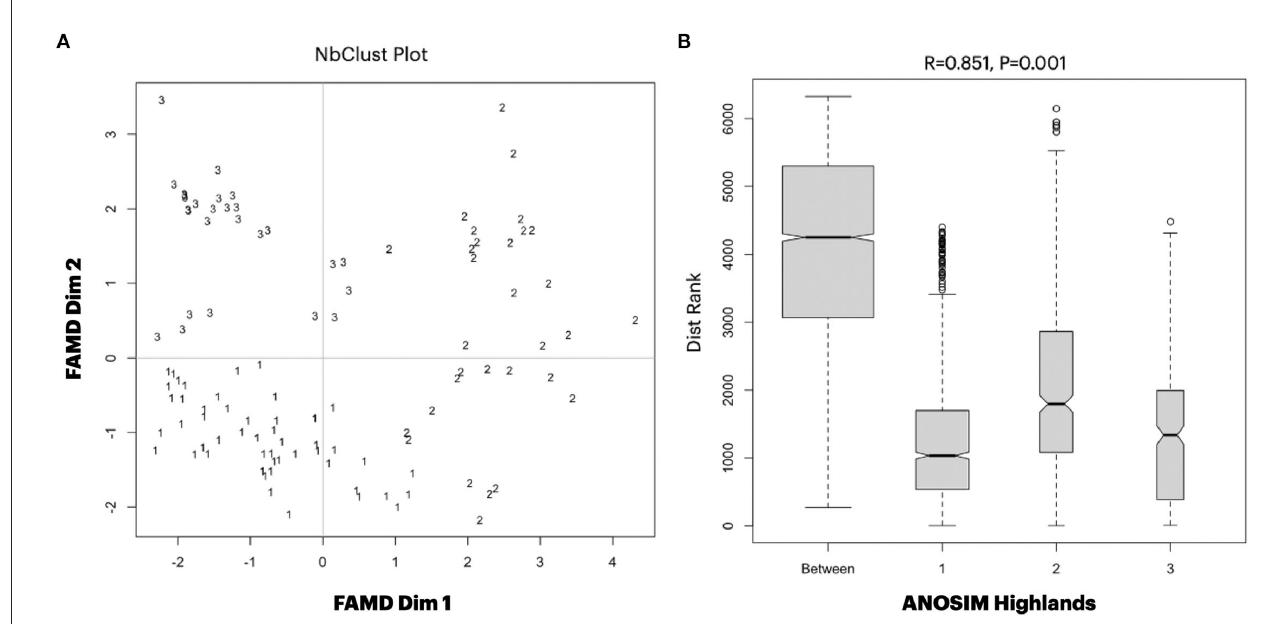
FIGURE5 Similarity analysis for farm typology. (A) Shows the cluster analysis from NbCluster. Each plot is displayed according to its coordinates in the FAMD, with an assigned management type ranging from 1 to 3. (B) Shows the results of the significance test with ANOSIM. The ANOSIM X-axis shows the significant differences calculated between groups (between) and within each group (1, 2, and